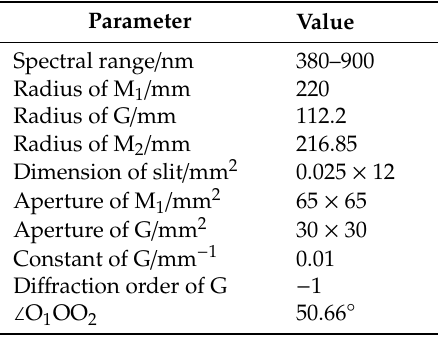
Table 1. Parameters of the model O ff ner imaging